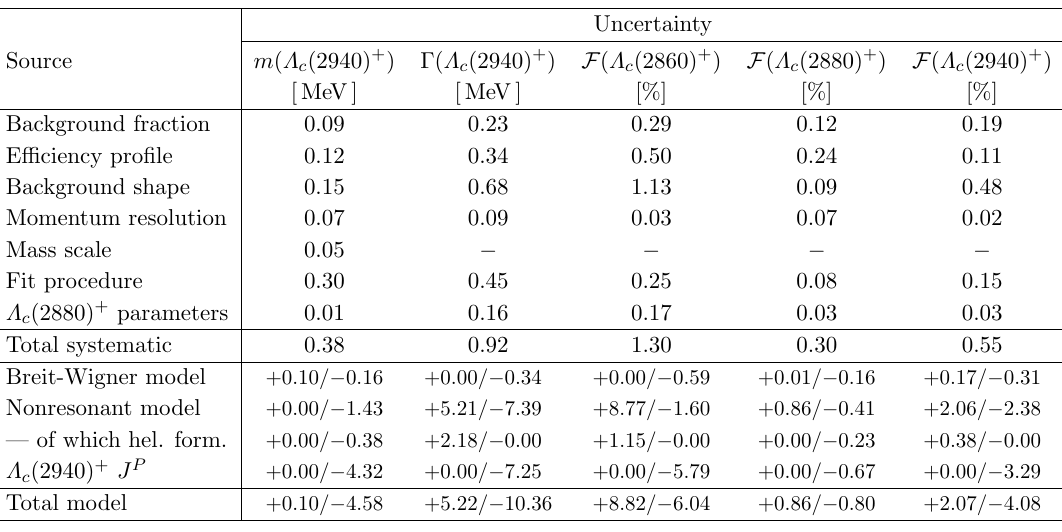
Table 9 . Systematic and model uncertainties of the (cid:3) c (2940) + parameters and the resonance (cid:12)t fractions. The uncertainty due to the nonresonant model includes a component associated with the helicity formalism, which for comparison is given explicitly in the table,